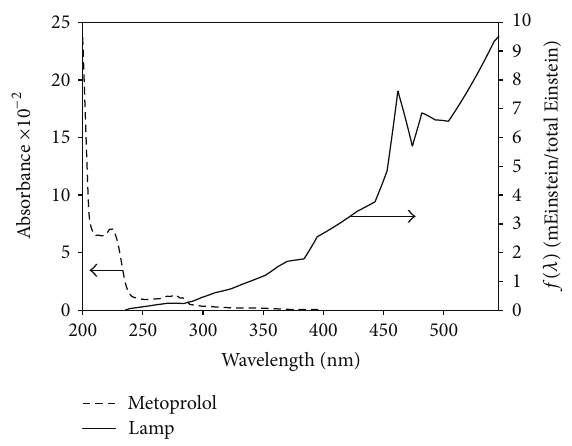
Figure 1: Absorbance spectrum of MET for aqueous concentration of 10mgL −1 (left axis) and lamp spectrum (right axis), where 𝑓(𝜆) represents the spectral distribution of the